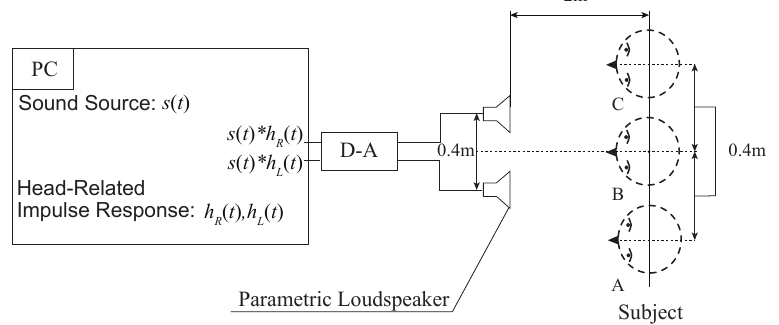
Figure 11. Experimental process: Subjects listened to a stereophonic sound at A, B and C. We then asked from which direction the sound was heard.